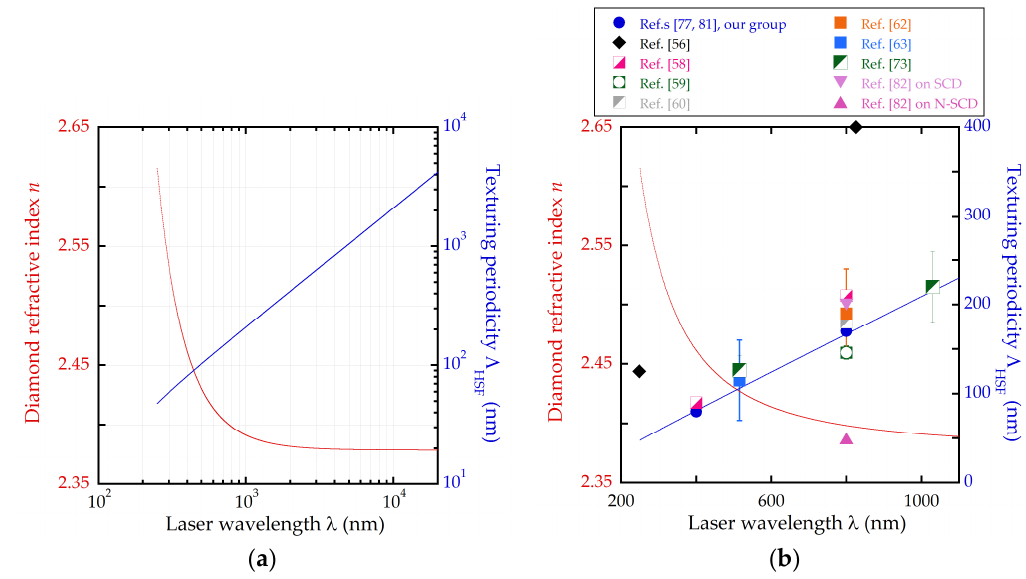
Figure 10. ( a ) Dependence of diamond refractive index [76] and related HSF texturing periodicity on the laser wavelength from about 200 nm to 20 μ m, derived from the application of Equation (1); ( b ) Detail of the plot shown in (a) for a restricted wavelength range 200–1100 nm and comparison with the experimental values of HSF reported in Table 1.